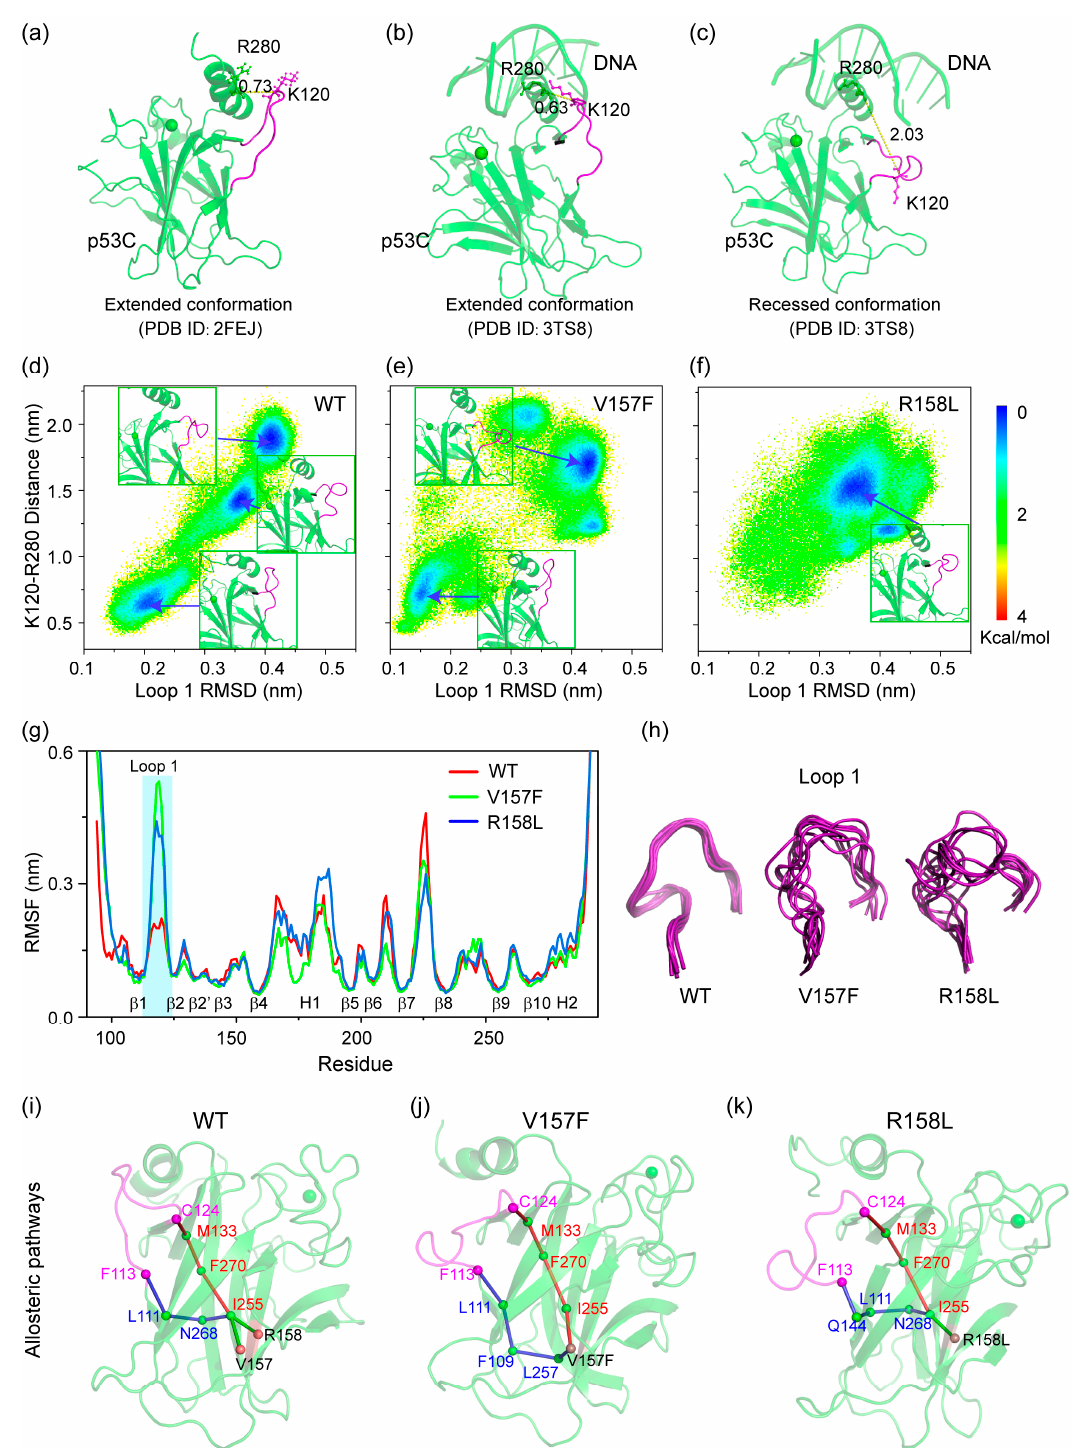
Figure 3. Effect of V157F and R158L mutations on the conformation and flexibility of loop 1. ( a ) The structure of WT p53C without DNA (PDB ID: 2FEJ). Loop 1 is colored magenta. The extended ( b ) and recessed ( c ) conformation of loop1 with DNA (PDB ID: 3TS8). Free energy surfaces (in kcal mol − 1 ) of WT p53C ( d ), V157F ( e ) and R158L ( f ), respectively, as functions of loop 1 RMSD and the distance between C α atoms of K120 and R280. ( g ) Average C α -RMSF of p53C. ( h ) Snapshots show the different flexibilities of Loop 1. Nine representative snapshots at the simulation time = 600, 650, 700, 750, 800, 850, 950 and 1000 ns were superposed with each other. ( i – k ) Snapshots of optimal and suboptimal allosteric paths from residue V157 or R158 to loop 1, showing sphere and stick representations.